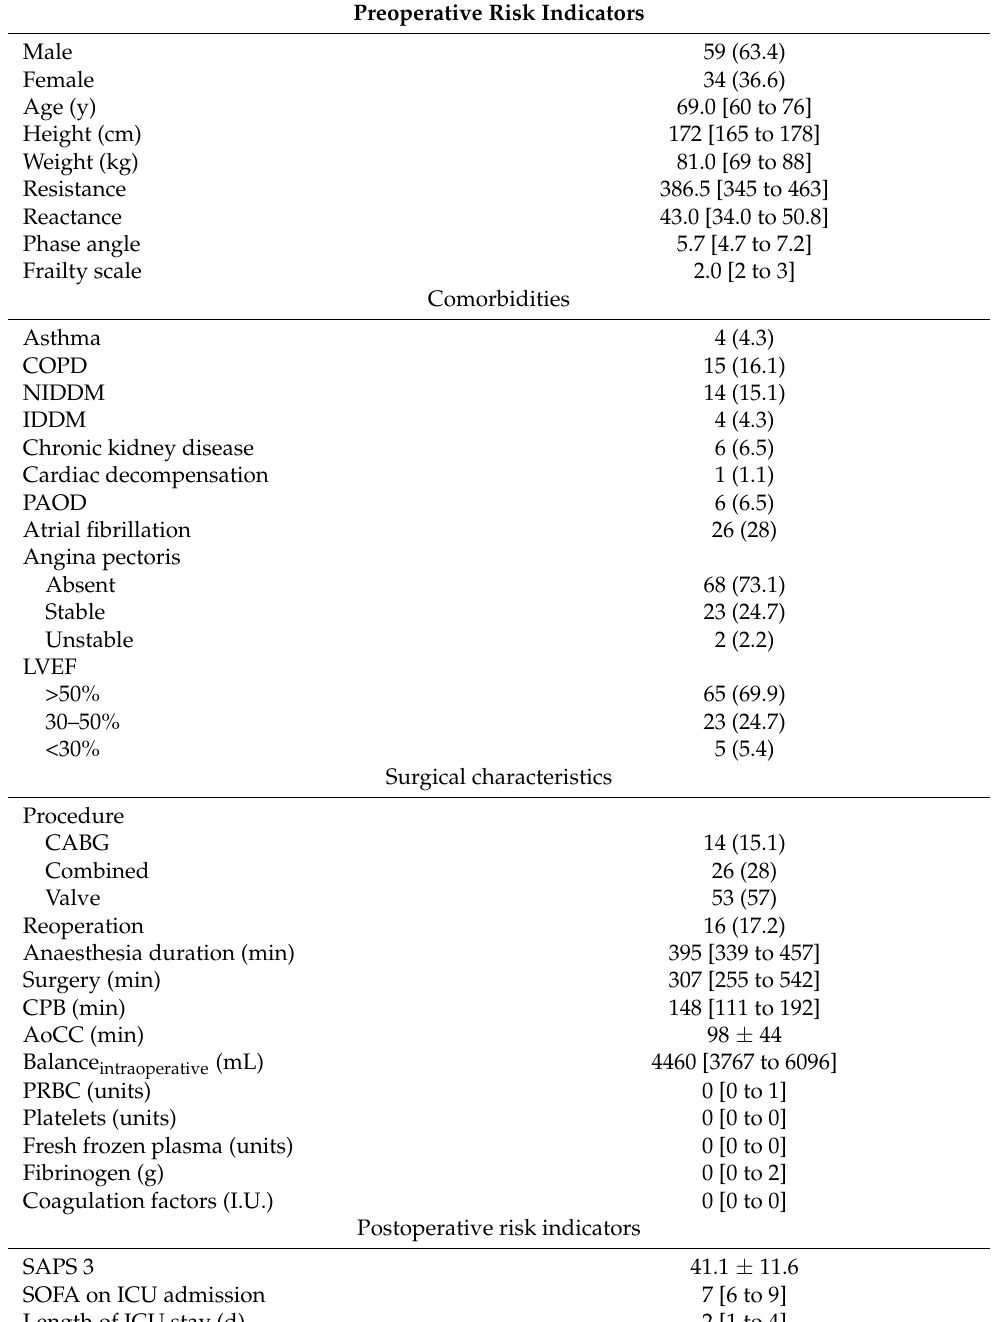
Table 1. Demographic and surgical